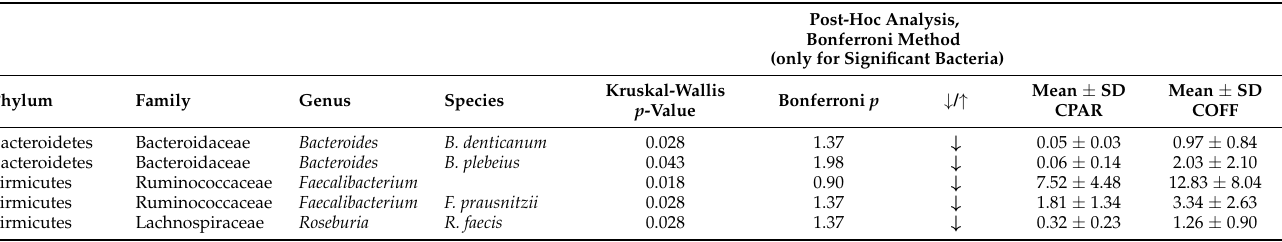
Table 5. Relative abundance differences of bacterial taxa between CPAR and